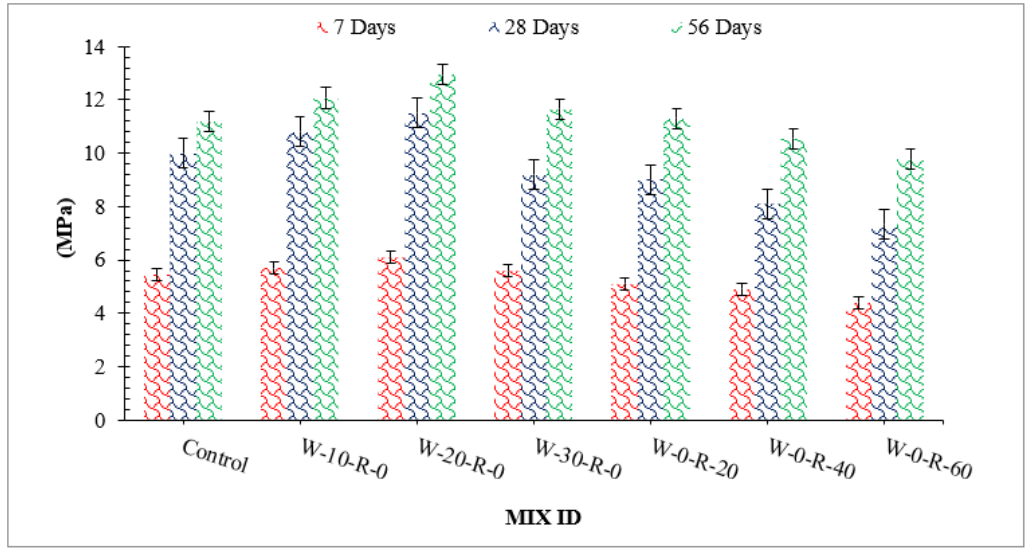
Figure 16. Punching strength.